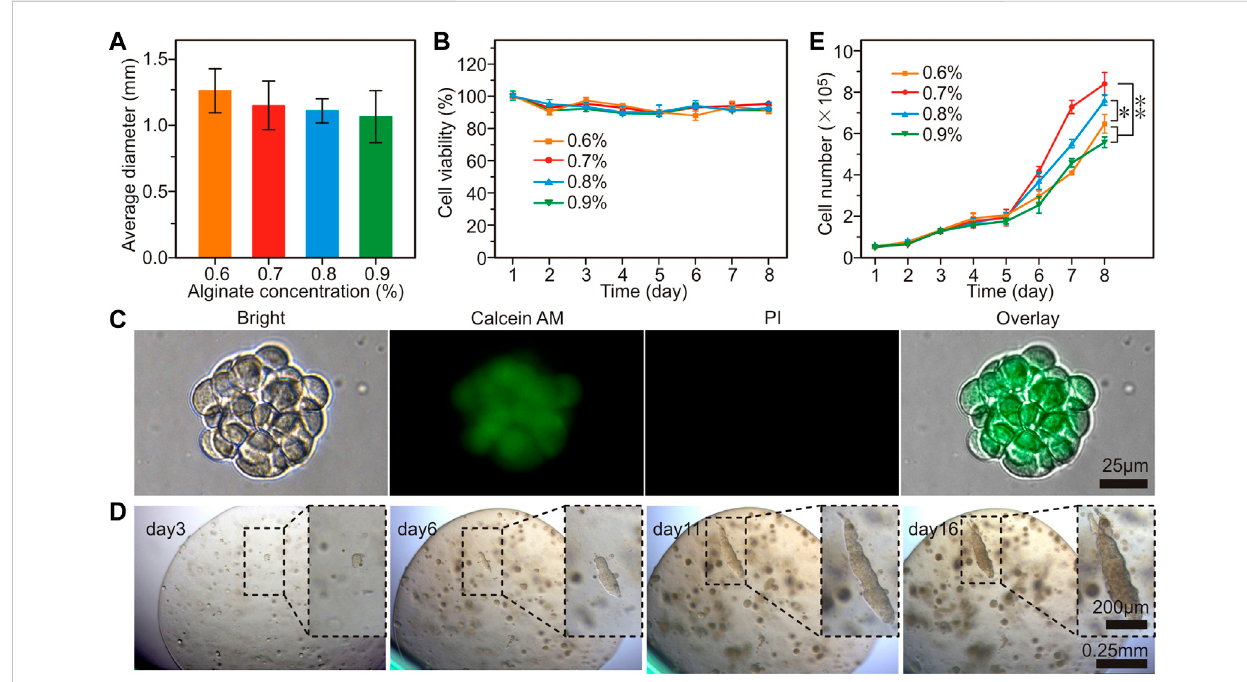
FIGURE 1 The proliferation of GC cells (MGC-803 cell as the representative) in alginate-based microspheres. (A) The average diameter of microspheres prepared with different concentrations of alginate. (B) Cell viability of the MGC-803 cells cultured in alginate microsphere. (C) Calcein-AM/PI staining of GC cell clusters released from alginate microspheres. (D) Dynamic morphology of MGC-803 cell clusters proliferated in 0.7% alginate microspheres. (E) Cell counting in different concentrations of alginate microspheres. n = 5 per group, *: p < 0.05, **: p <